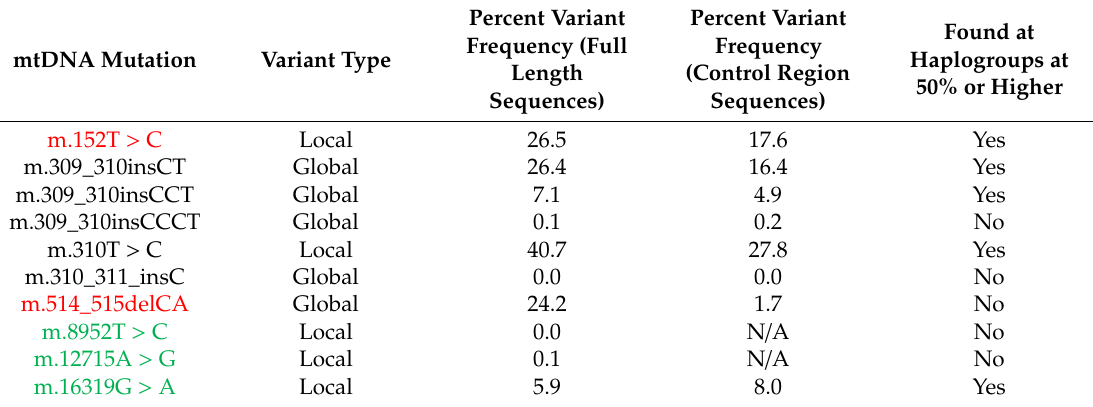
Table 3. Prevalence of mtDNA mutations identified in hPSC-CMs using MITOMAP database. Green, potential HCM protective variants; red, potential HCM aggravator